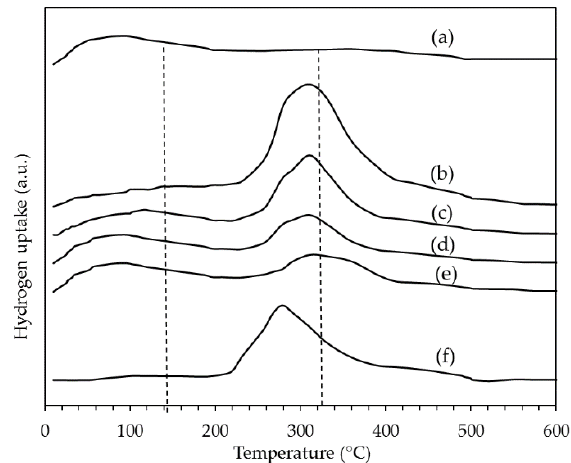
Figure 2. TPR of the catalysts: ( a ) 2Ag / AW; ( b ) 1PtAg / AW; ( c ) 0.4PtAg / AW; ( d ) 0.25PtAg / AW; ( e ) 0.1PtAg / AW; ( f ) 0.4Pt / AW catalyst.